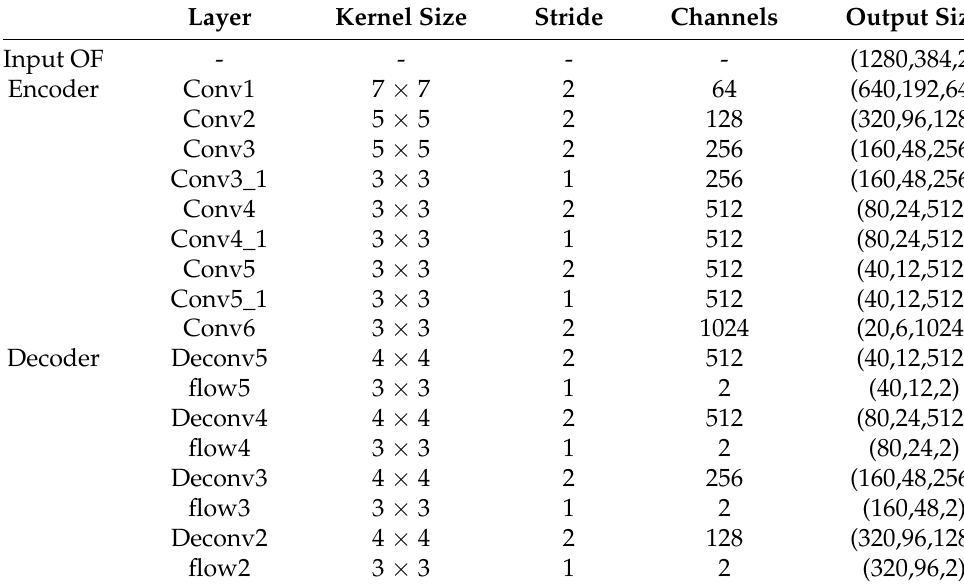
Table 1. Parameter settings of the encoder and the